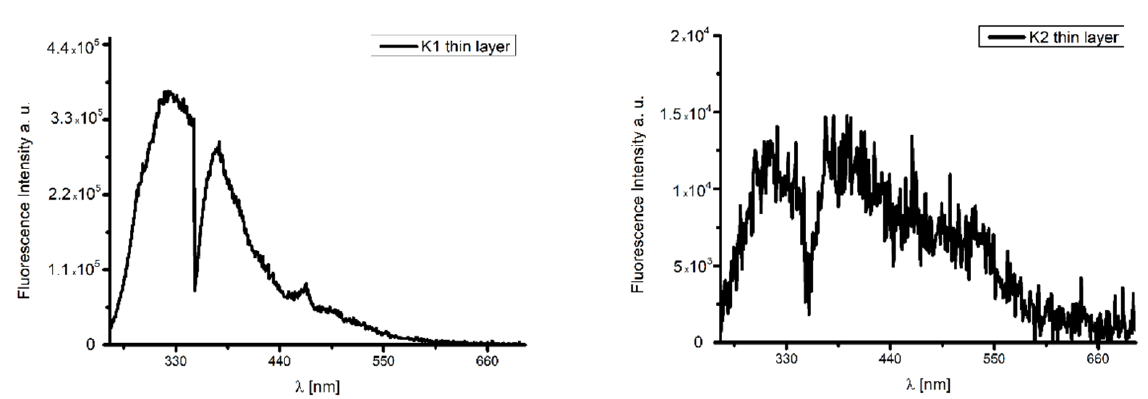
ex = 320 nm, spin coating.